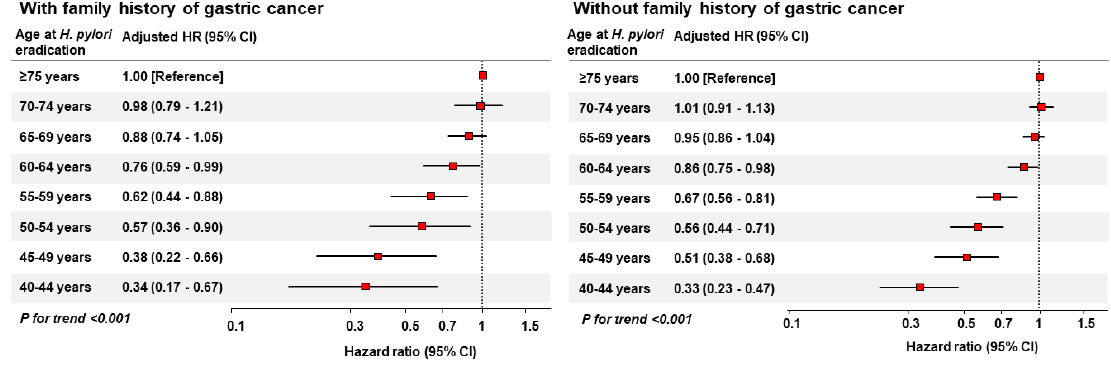
Figure 2. Risk of gastric cancer according to age at H. pylori eradication in patients with and without a family history of gastric cancer. H. pylori , Helicobacter pylori; HR, hazard ratio; CI, confidence interval. 3.3. Risk of GC According to Age at H. pylori Eradication in Patients without a Family History The mean follow-up period was 4.76 years, with a maximum of 6 (median, 4.75; IQR 4.27–5.22) years in patients without a family history of GC. During the follow-up period, among 1,594,109 patients without a family history of GC, 9332 (0.6%) developed GC. Table 3 shows the risk of GC in relation to age at H. pylori eradication in patients without a family history of Table 3. Risk of gastric cancer according to age at H pylori eradication in patients without a family history of gastric cancer.